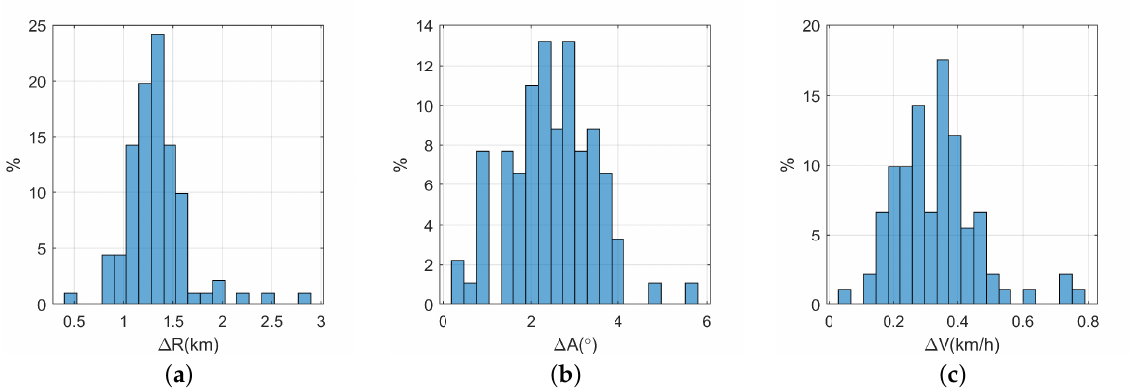
Figure 10. Kinematic parameter error distributions for target 2. ( a ) Range error distribution.